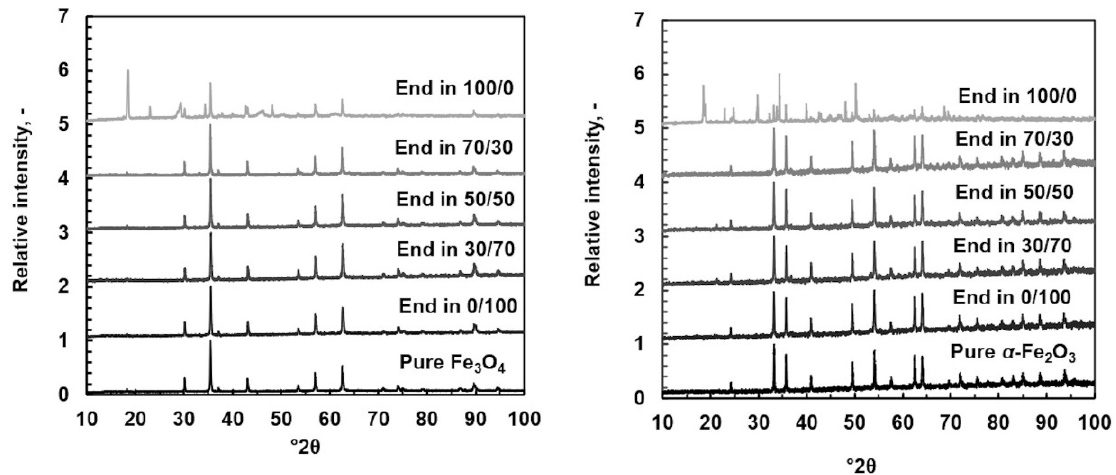
Figure 7. XRD patterns for original powder and dissolved in different (Ox/HNO 3 ) systems at 35 °C. Original powder: magnetite on the left and hematite on the right.